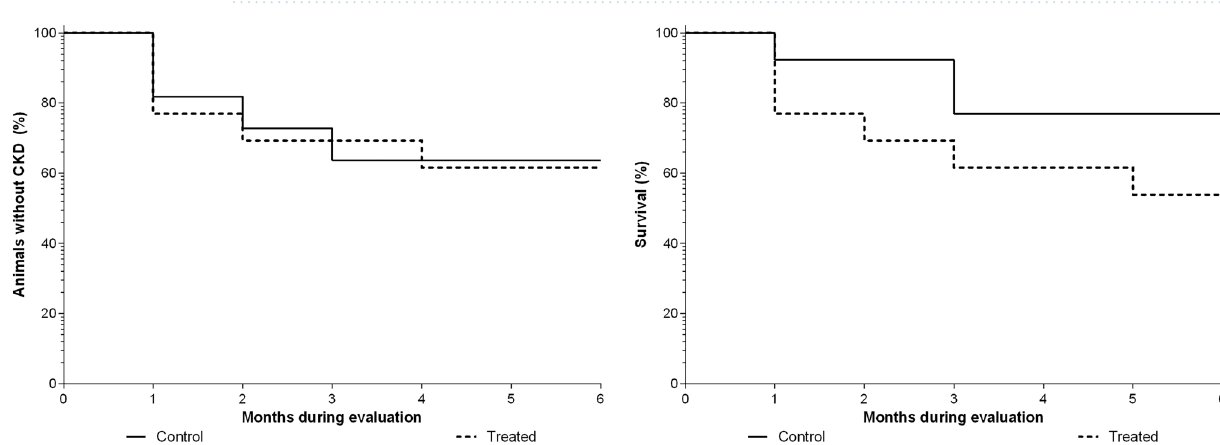
Figure 3. Kaplan Maier survival curves for analysis of chronic renal insufficiency (CKD, left) and mortality (right), in bitches with mammary carcinoma with (TG) or without (CG) carprofen at 4.4 mg/kg/day for 90 days, evaluated during 6